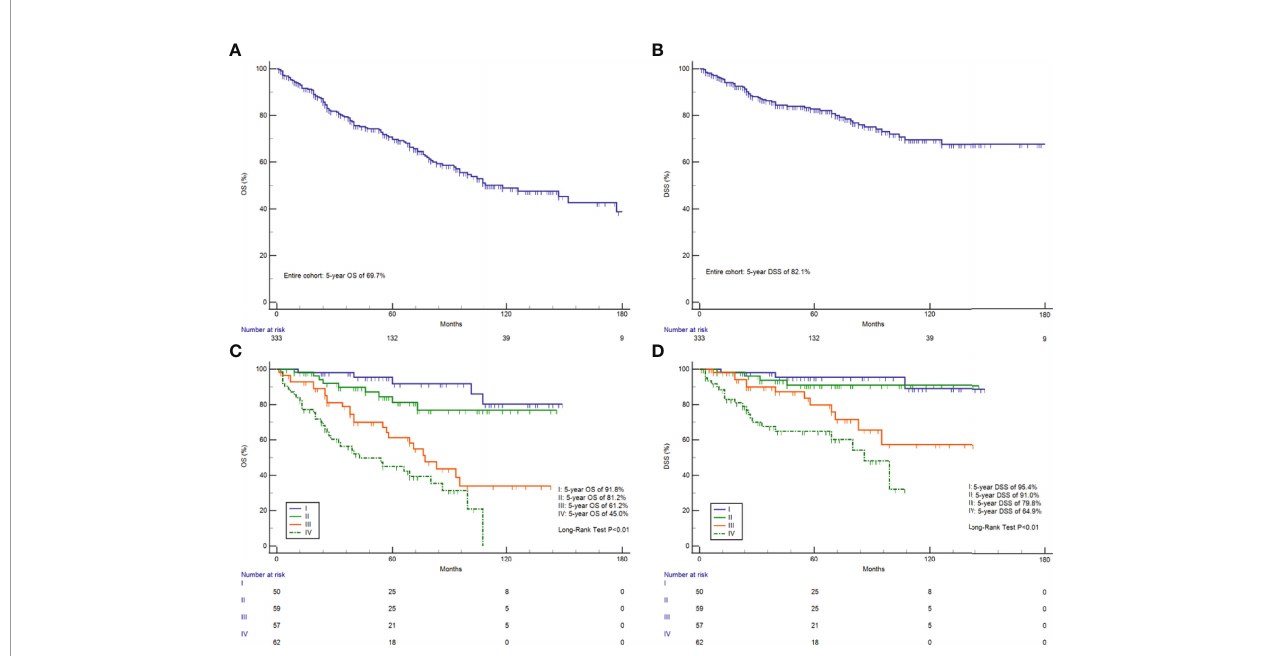
FIGURE 1 | Survival analysis. OS (A) and DSS (B) in all 333 HNMM patients; OS (C) and DSS (D) analysis strati fi ed by AJCC-TNM